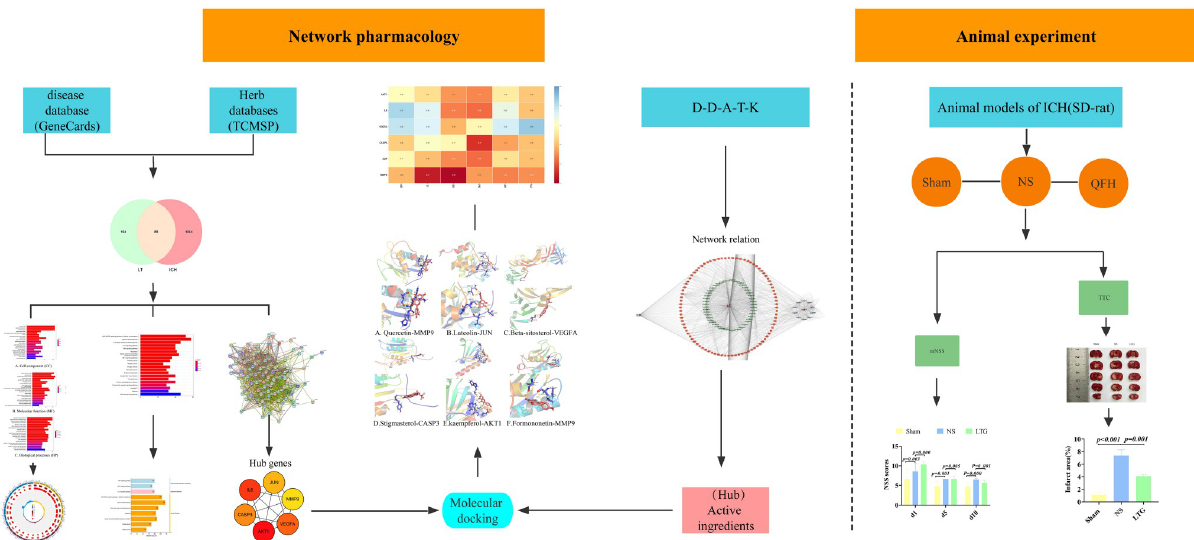
Fig 1. Mind map. Note: Modern bioinformatics combined with network pharmacology techniques were applied to explore the mechanism of action of LTG on ICH in conjunction with animal experiments.